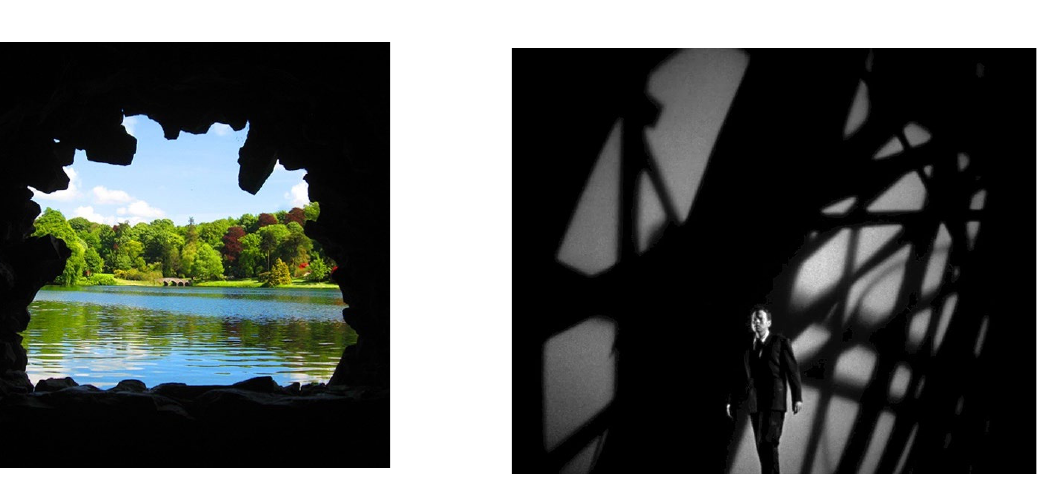
Figure 6 Michael O'Hara wanders in the crazy house in The Lady from Shanghai.